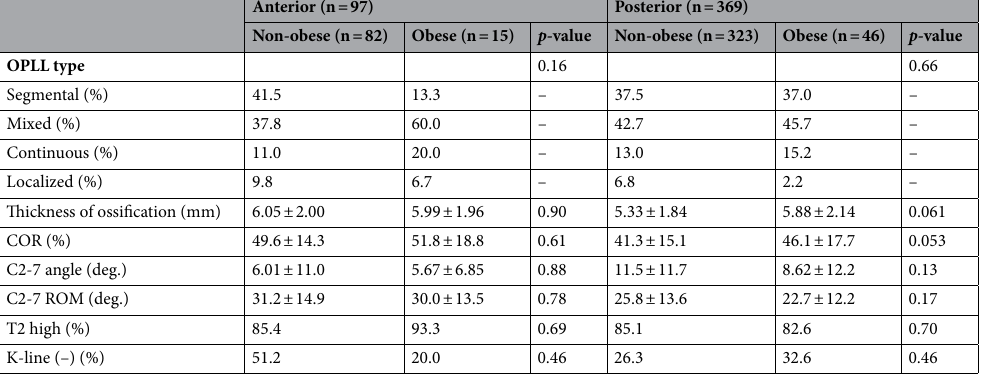
Table 5. Patients’ radiographical data stratified by approach. Non-obese: BMI < 30.0 kg/m 2 ; Obese: BMI ≥ 30.0 kg/m 2 ; BMI: body mass index; OPLL: ossification of the posterior longitudinal ligament; COR: